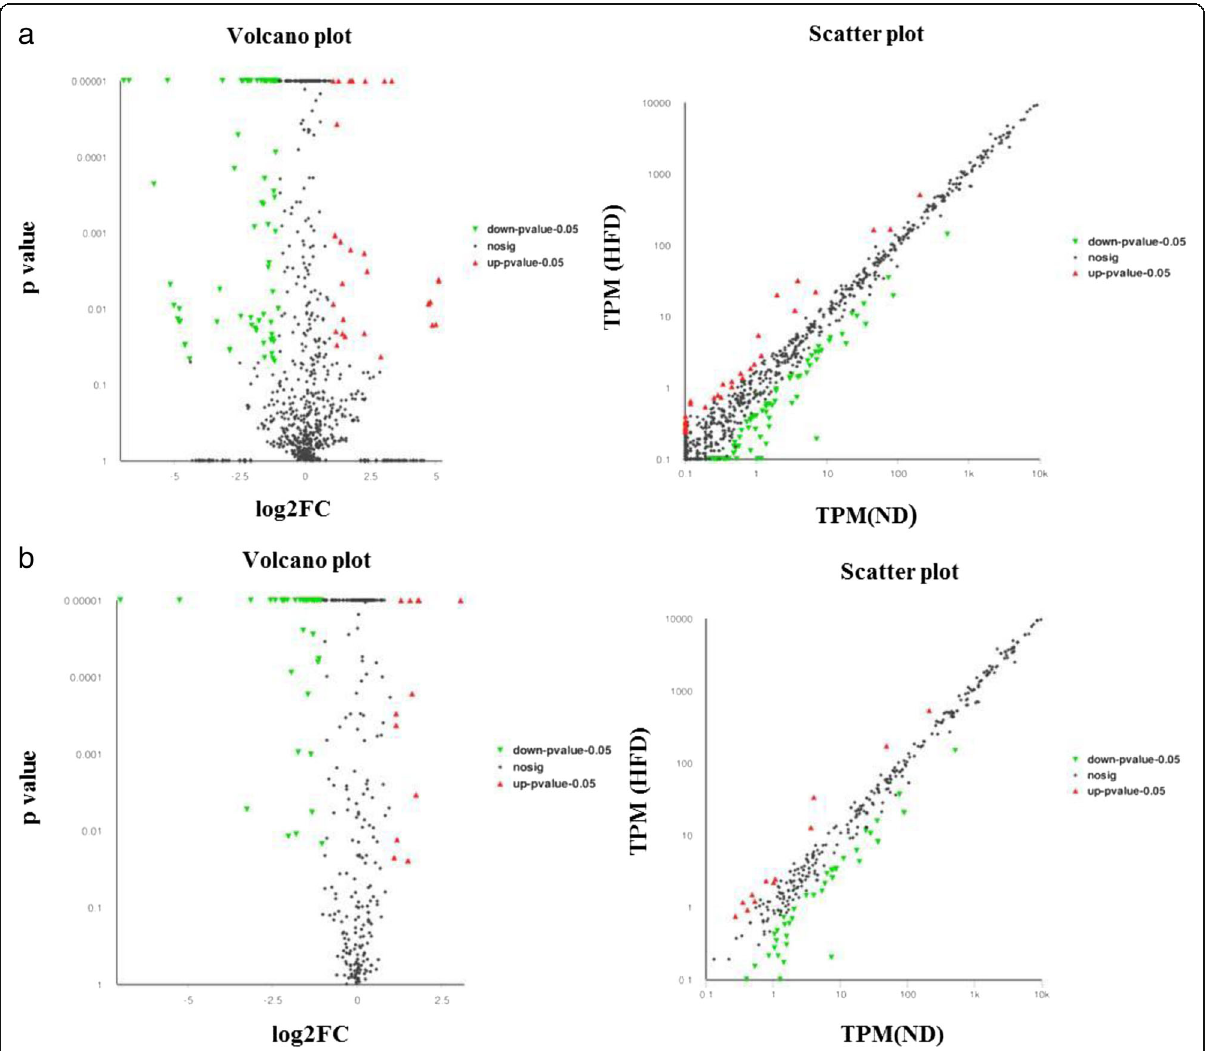
Fig. 4 The volcano plot and scatter plot of the known ( a ) and novel ( b ) differentially expressed miRNAs between the two groups. Red spots represent upregulated miRNAs, and green spots indicate downregulated miRNAs. Back spots represent miRNAs that did not show obvious changes between the ND and HFD groups. ND, normal diet mice; HFD, high-fat diet